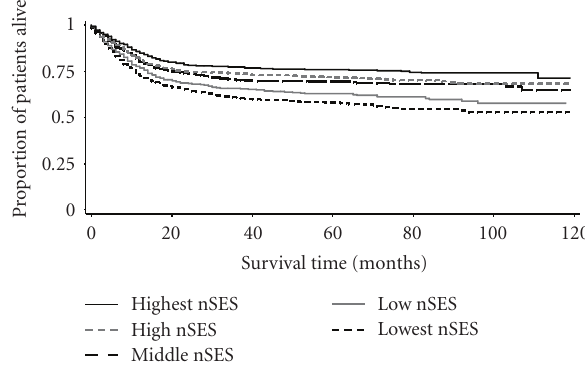
Figure 2: Unadjusted Kaplan-Meier survival curves ( N = 3,489) by neighborhood-level socioeconomic status